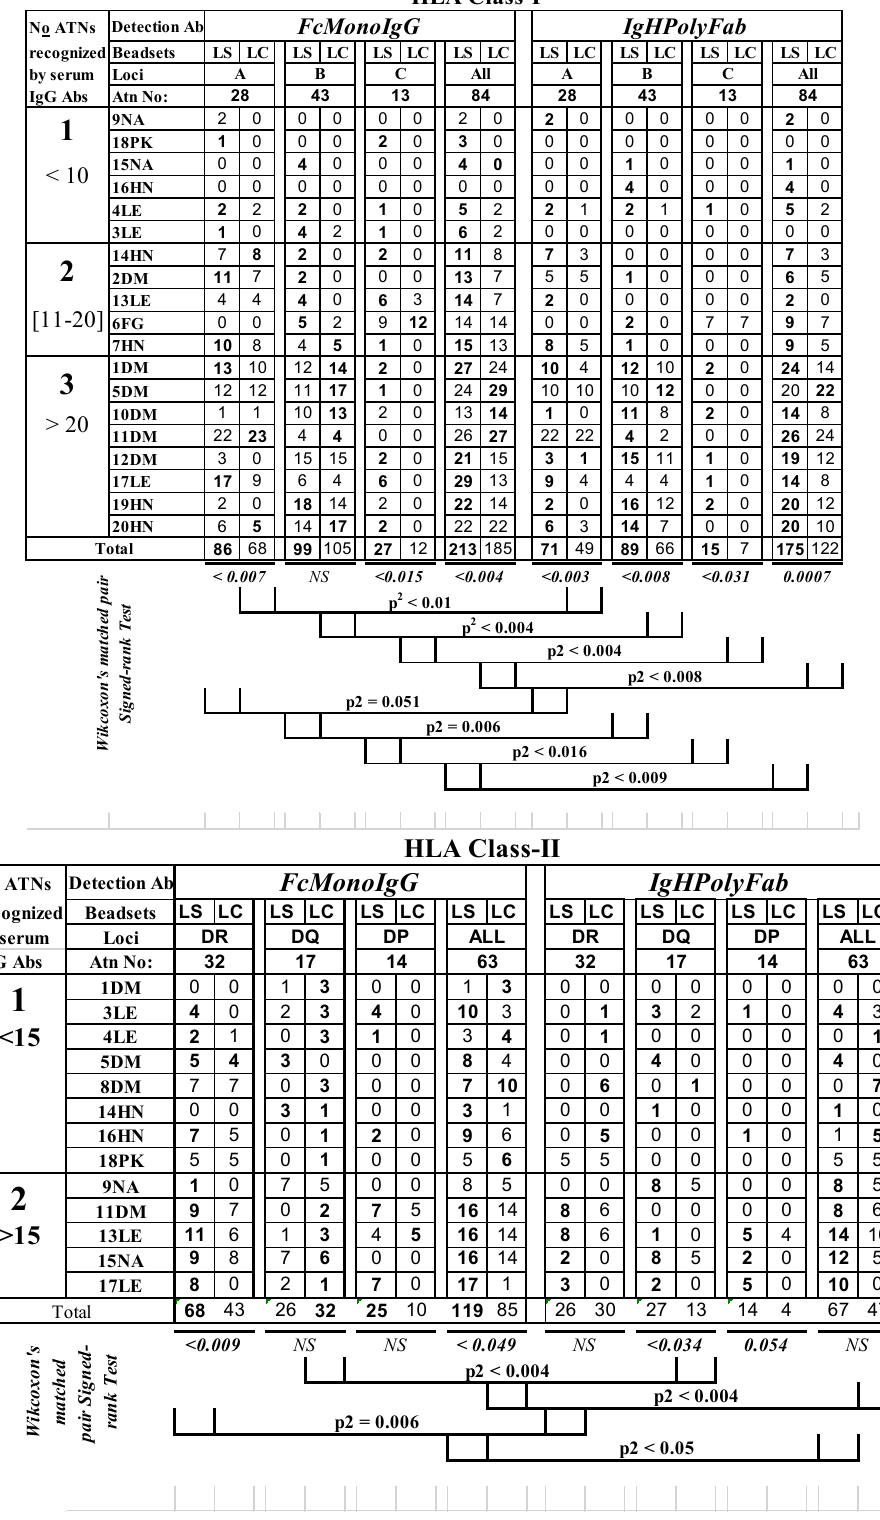
Figure 1. Profiles of sensitization estimated by the number of HLA class I and class II antigens, recognized by the IgG antibodies in the ESRD patients’ sera, significantly differ between the two different SABs, LABScreen (LS) and LIFECODES (LC), and with two different detection Abs ( FcMonoIgG and IgHPolyFab ). The nature of disease in the ESRD are